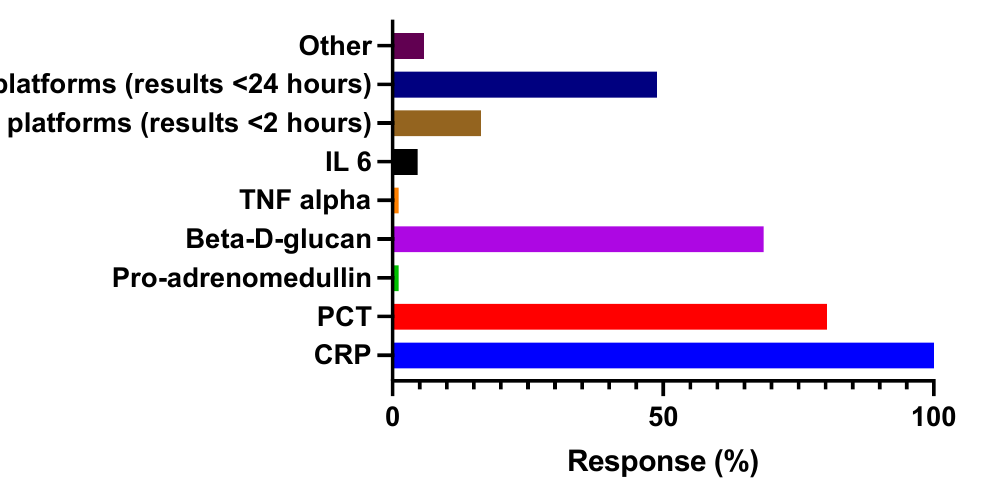
Figure 2. Routine access to biomarkers and rapid molecular diagnostics. CRP: C-reactive protein. PCT: Procalcitonin. IL6: Interleukin 6. TNF-alpha: (tumor necrosis factor-alpha). PCR: Rapid molecular PCR—for single or multiple respiratory pathogens.